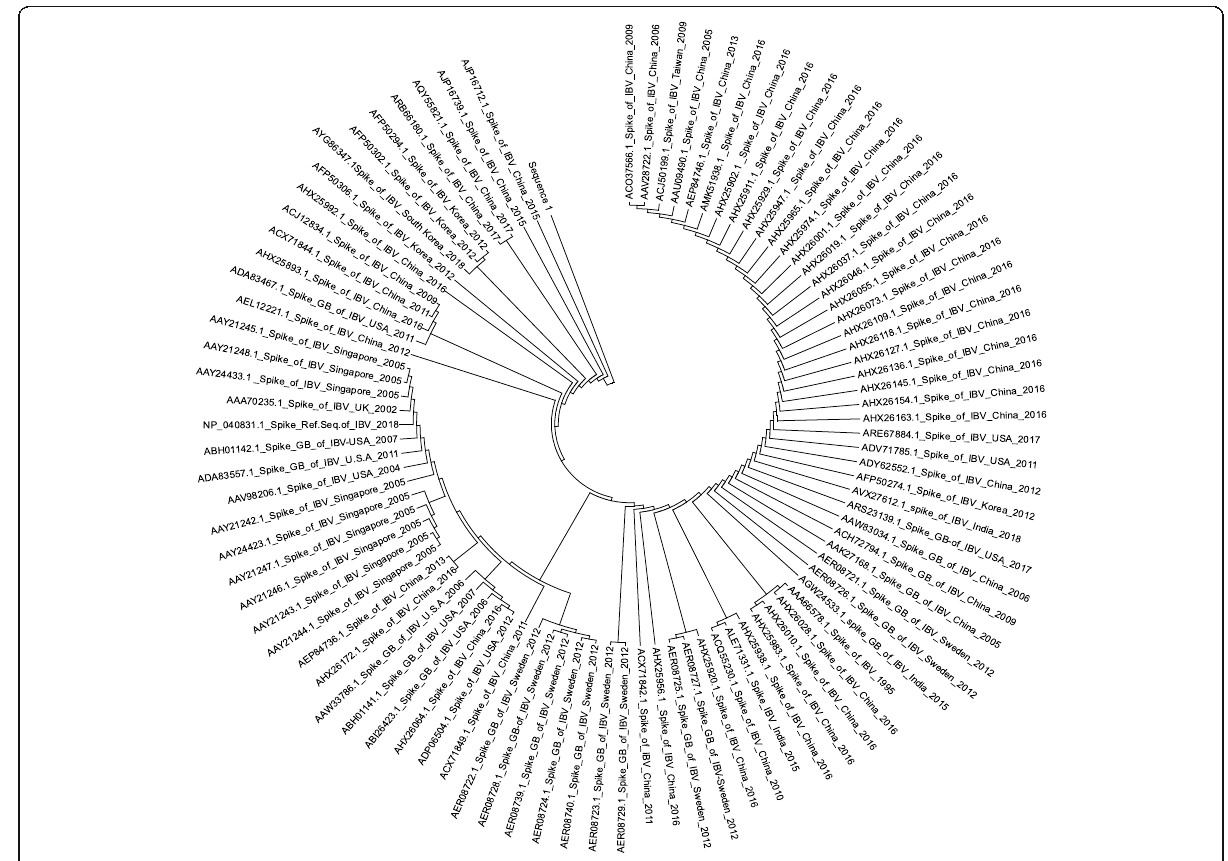
Fig. 4 Phylogenetic tree of retrieved strains of spike protein using MEGA7.0.26